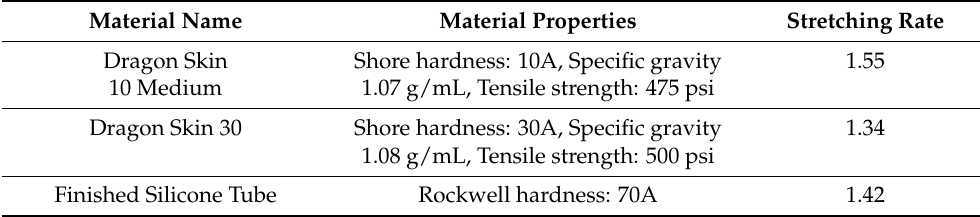
Table 1. Millirobot materials and